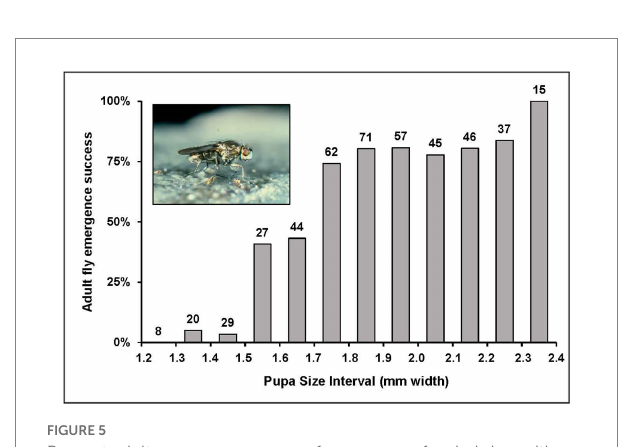
FIGURE 5 Percent adult emergence success from pupae of varied size, with standard error and sample size above each bar. Pupae derived from experimental exposures of larvae to varied salinity along with pupae collected from both Mono Lake and Lake